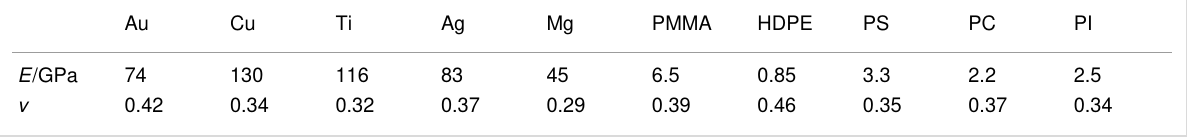
Table 2: Mechanical parameters of different materials used in the theoretical analysis and FEA calculations. Au Cu Ti Ag Mg